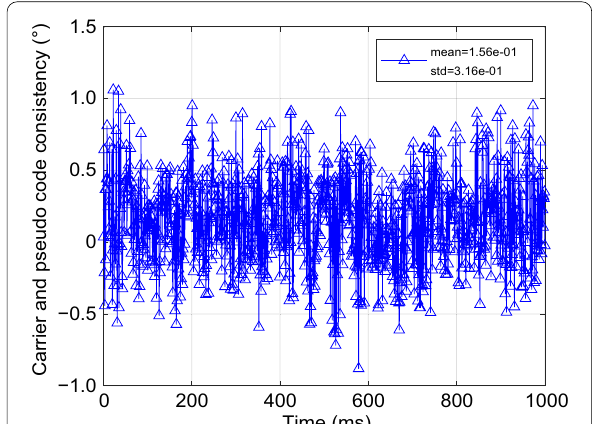
Fig. 19 Carrier and pseudo code consistency of BDS-3 GEO-1